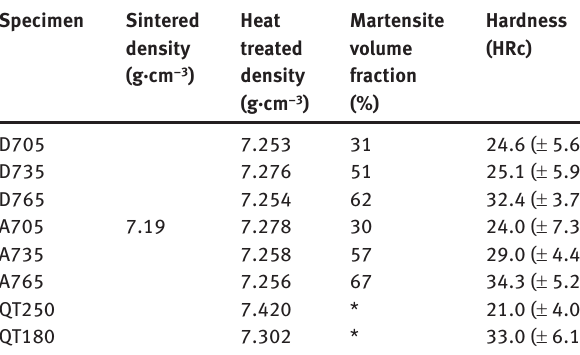
Table 1: The density, martensite volume fraction and hardness properties of specimens Specimen